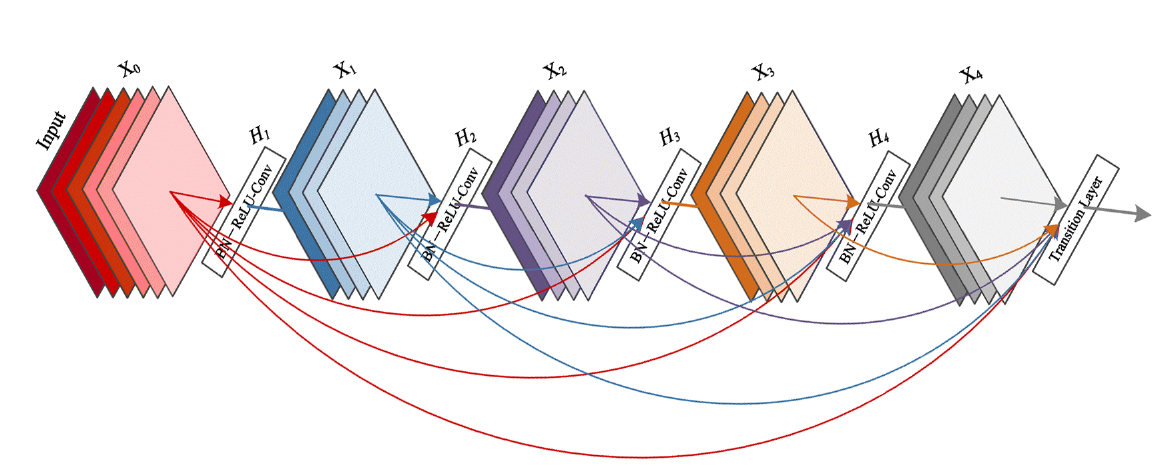
Figure 10. A 5-layer dense block with a growth rate of k = 4. Each layer takes all preceding feature maps as input [35].